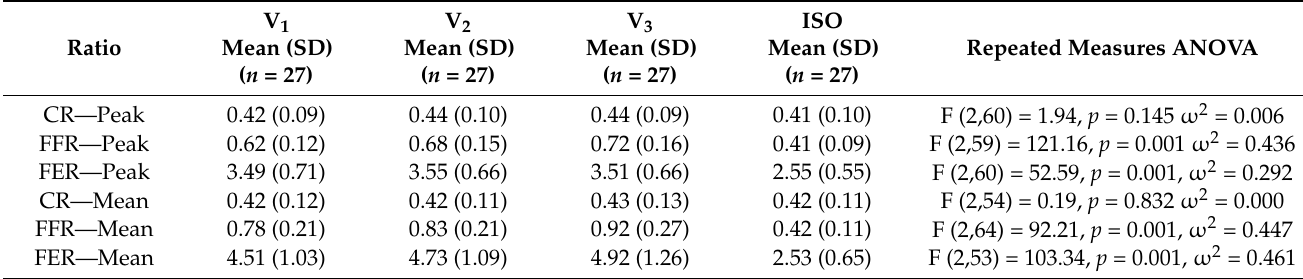
Repeated Measures